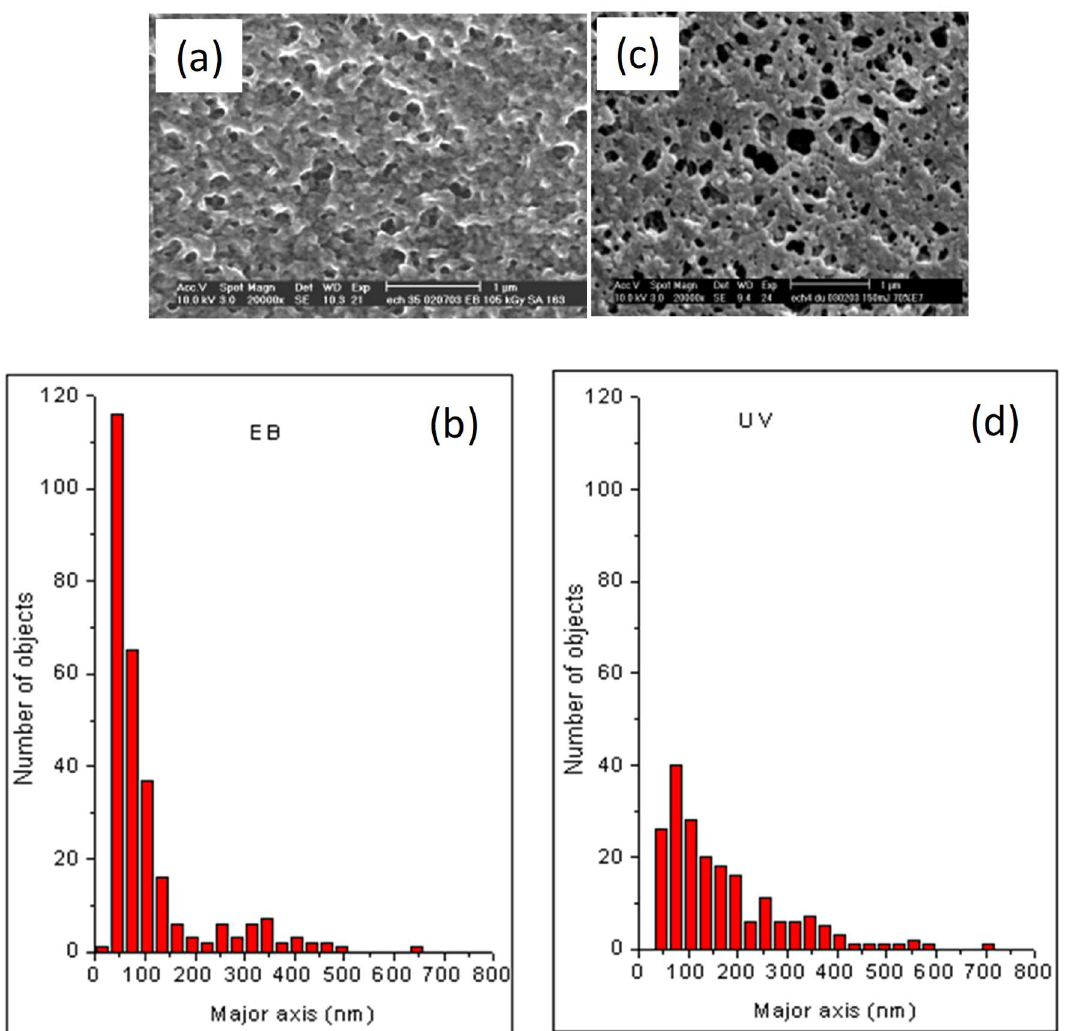
Figure 7. ( a ) A representative micrograph obtained from SEM observations is presented, showing the morphology of an EB-cured 30 wt.% of TPGDA/70 wt.% of E7 film. ( b ) Histogram obtained by image processing of the SEM picture from Figure 7a, taking into account the size distribution of the LC domains, and assuming the presence of ellipsoids characterized by a major and a minor axis. The corresponding SEM analysis of a UV-cured 30 wt.% of TPGDA/70 wt.% of E7 film is given in ( c , d ). In both cases, the same experimental conditions were used for the morphological observations of the